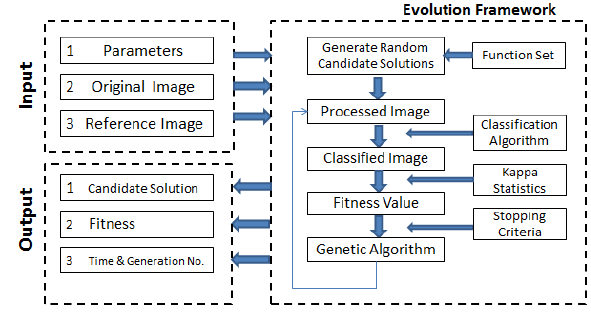
Figure 2. Main datasets and processing operations of the evolutionary